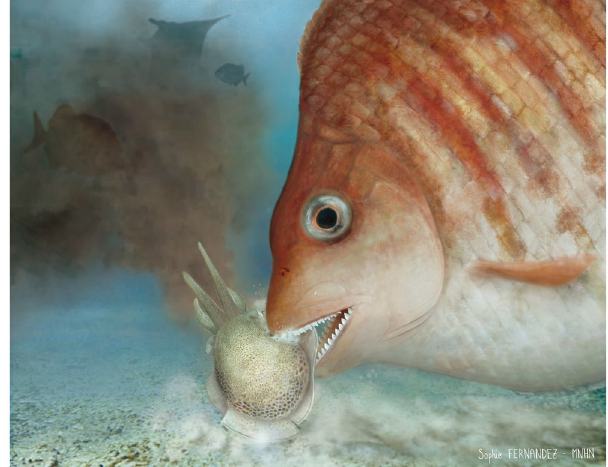
Figure 5. Life reconstruction of Serrasalmimus secans gen. et sp. nov. This reconstruction illustrates the putative feeding behaviour of this piranha-jawed pycnodont, as predator of soft-bodied animals such as cuttlefishes (foreground) and facultative ectoparasite of large animals such as primitive devil rays (background). The head, squamation and body outline are based on Gyrodus , the most closely related pycnodont taxon known from complete skeletons (Artwork by Sophie Fernandez –